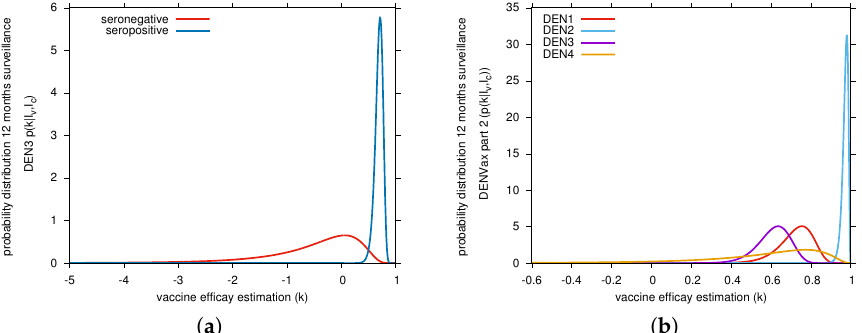
Figure 1. Bayesian estimate of DENVax vaccine efficacies (VE) against virologically confirmed dengue for the first 12-month surveillance (part 1). In ( a ) DEN3 serotype-specific vaccine efficacy by serostatus. Red and blue curves show our estimates for the seronegative and seropositive individuals, respectively. In ( b ) serotype-specific VE estimations. The raw data used to estimate the distribution by dengue serotype for individuals aged 4–16 years old was obtained in [9] and are shown in Table 1. High vaccine efficacy for dengue serotype 2 and intermediate to low vaccine efficacy for the other serotypes are